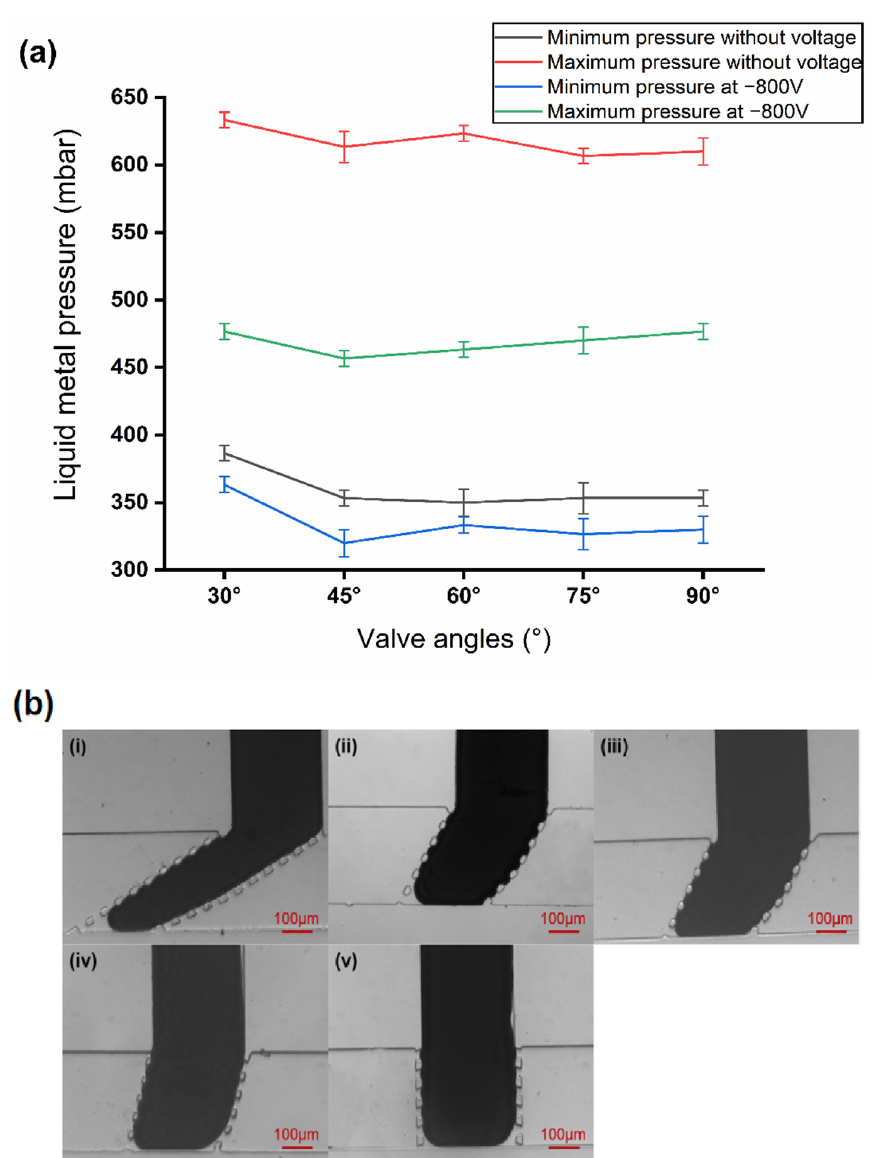
Figure 3. Study on valve closing conditions and valve closing diagram. ( a ) Liquid metal pressure ranges required for valve closing with and without voltage applied. ( b ) Different types of microvalves in closed state: ( i ) 30 ◦ inclination angle, ( ii ) 45 ◦ inclination angle, ( iii ) 60 ◦ inclination angle, ( iv ) 75 ◦ inclination angle, ( v ) 90 ◦ inclination angle.